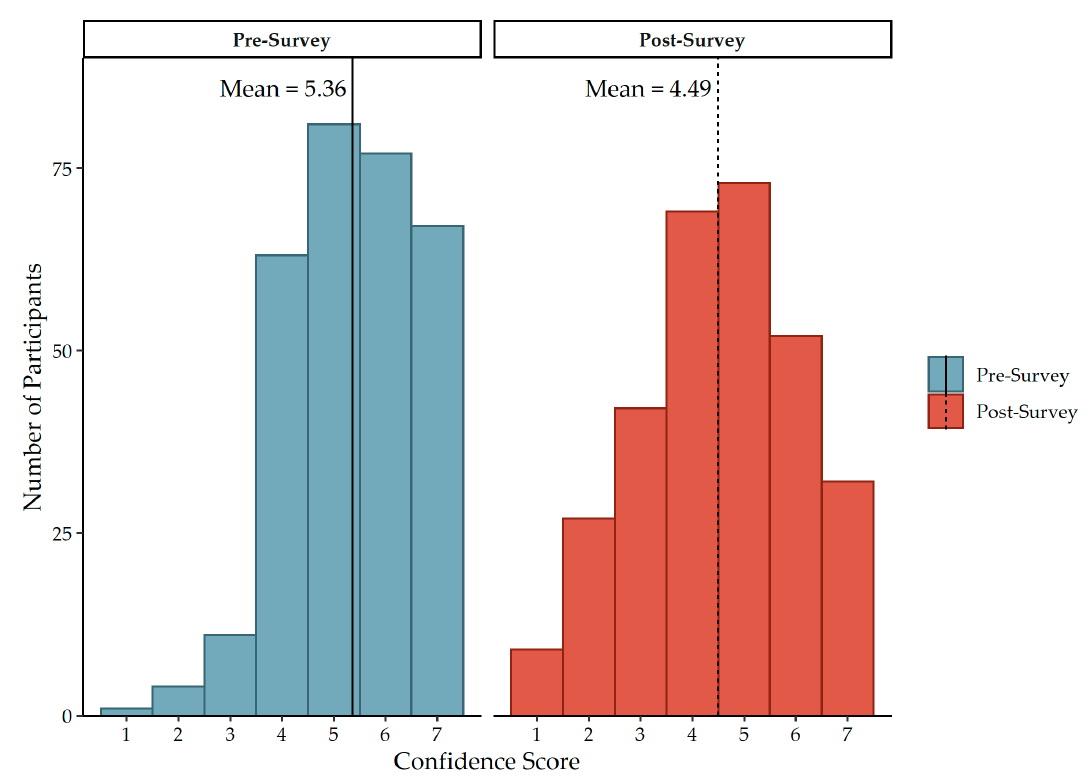
Figure 3. Distribution of confidence score, before and after code identification survey.